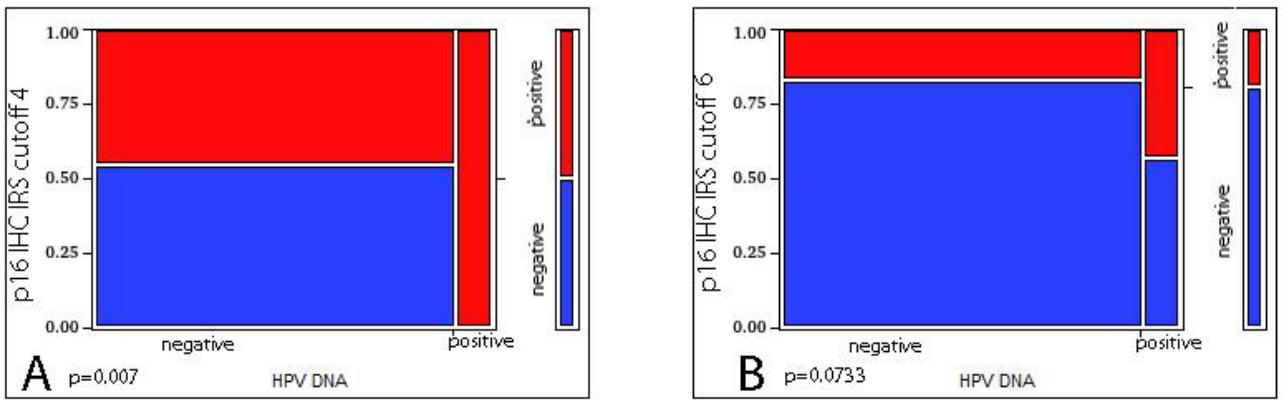
Figure 1. Flowchart describing the availability of data for different patient groups.